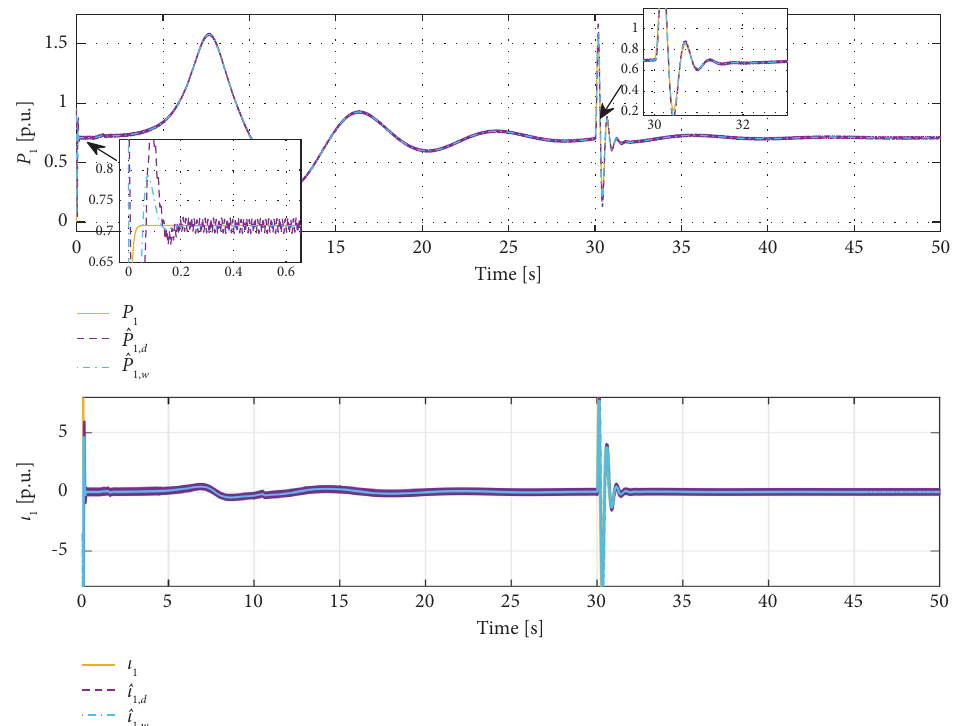
Figure 3: Comparison between the L-D GE estimators: the electrical power and nonlinear interconnection term of generator